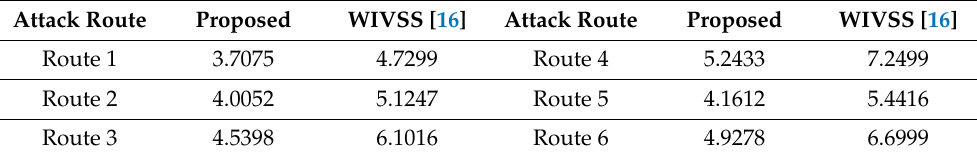
Table 10. Comparative experimental